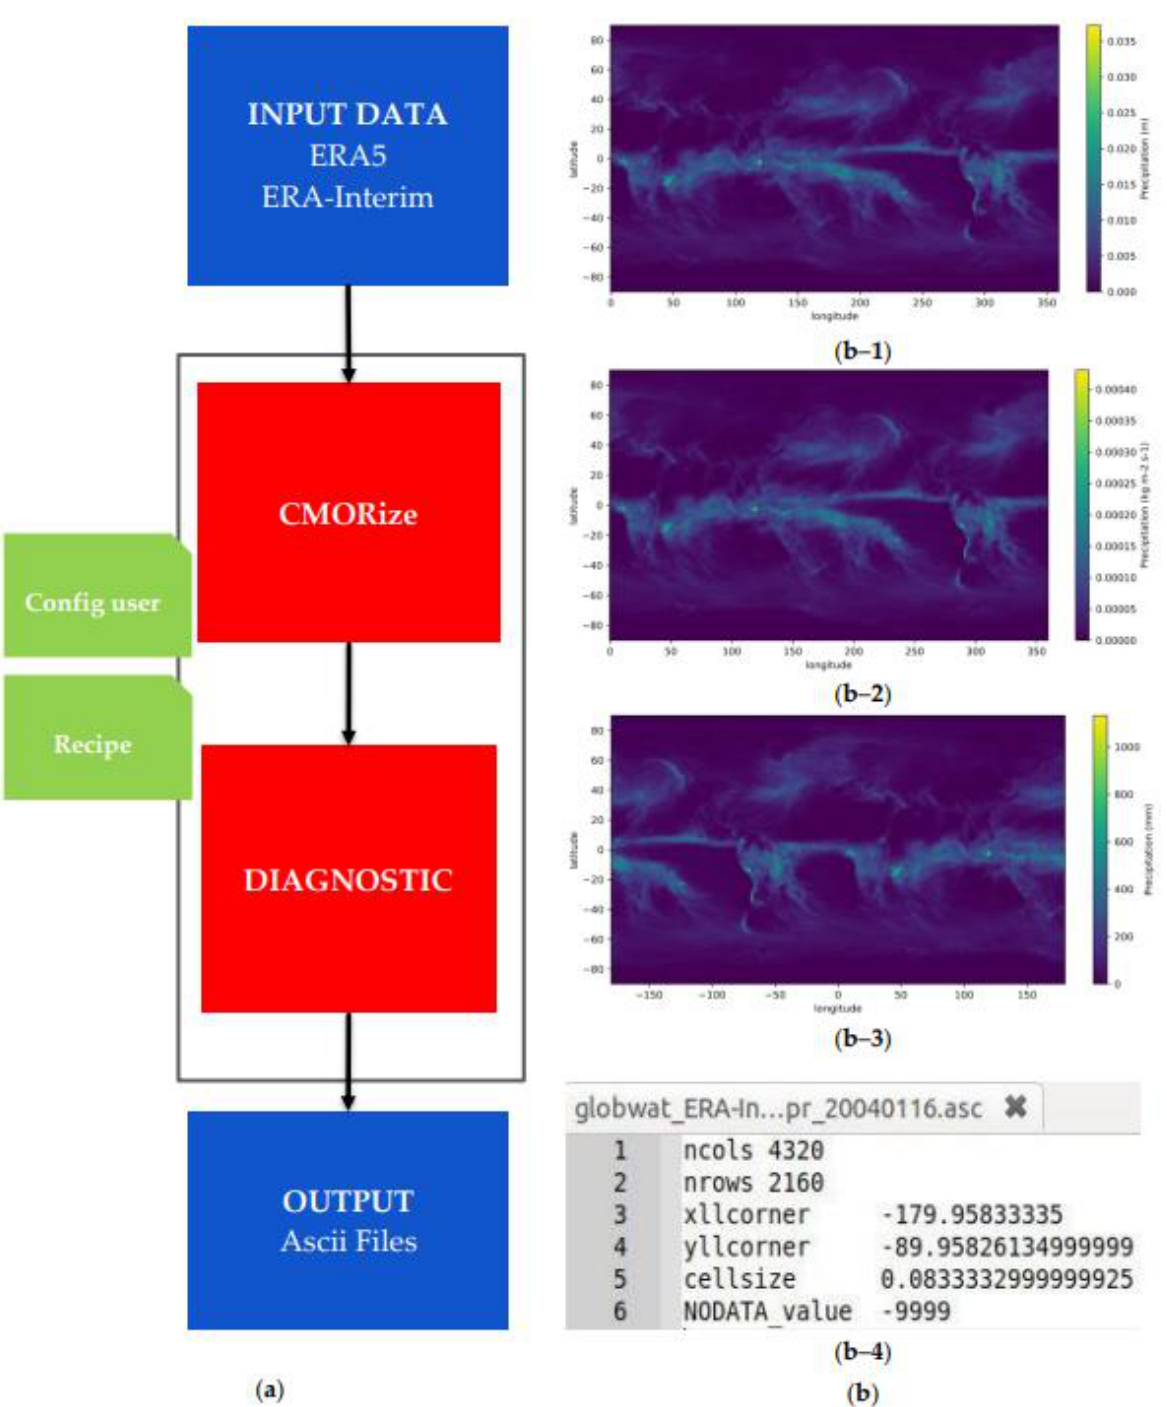
Figure 1. ( a ) The processing flowchart; ( b ) Processing example for January precipitation from ERA- Interim dataset; ( b–1 ) Raw data; ( b–2 ) CMORized data; ( b–3 ) Data after application of diagnostic; ( b–4 ) Data in the GlobWat input format . ( b–4 ) Data in the GlobWat input